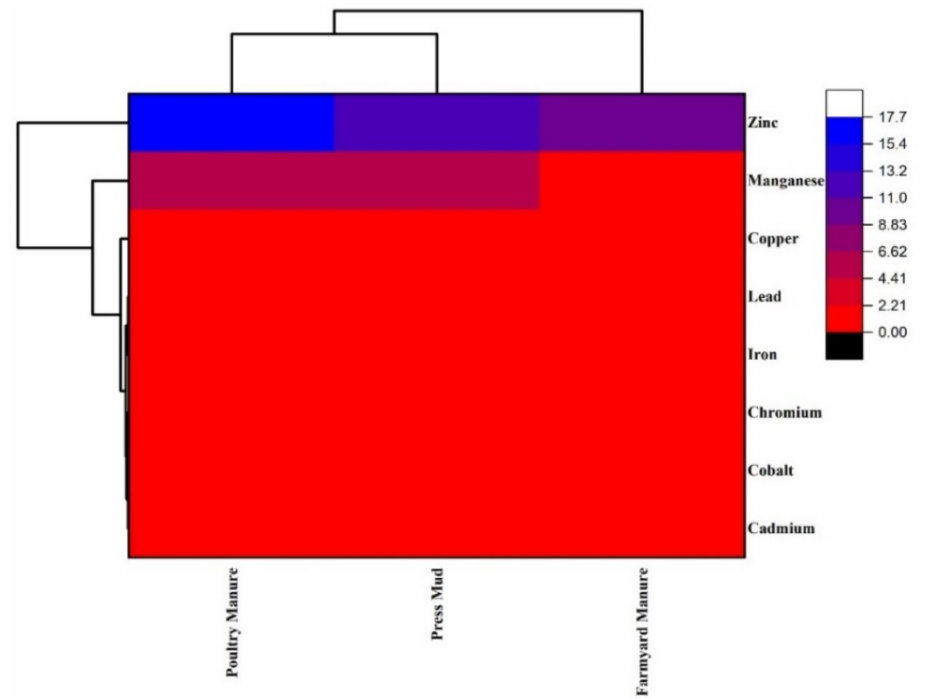
Figure 2. Dendrogram of 8 metals (copper, cobalt, chromium, cadmium, lead, iron, manganese, zinc) based on different treatment groups (poultry waste, press mud, and farmyard manure) from soil samples. It was generated with a hierarchical cluster analysis with Average Linkage (between